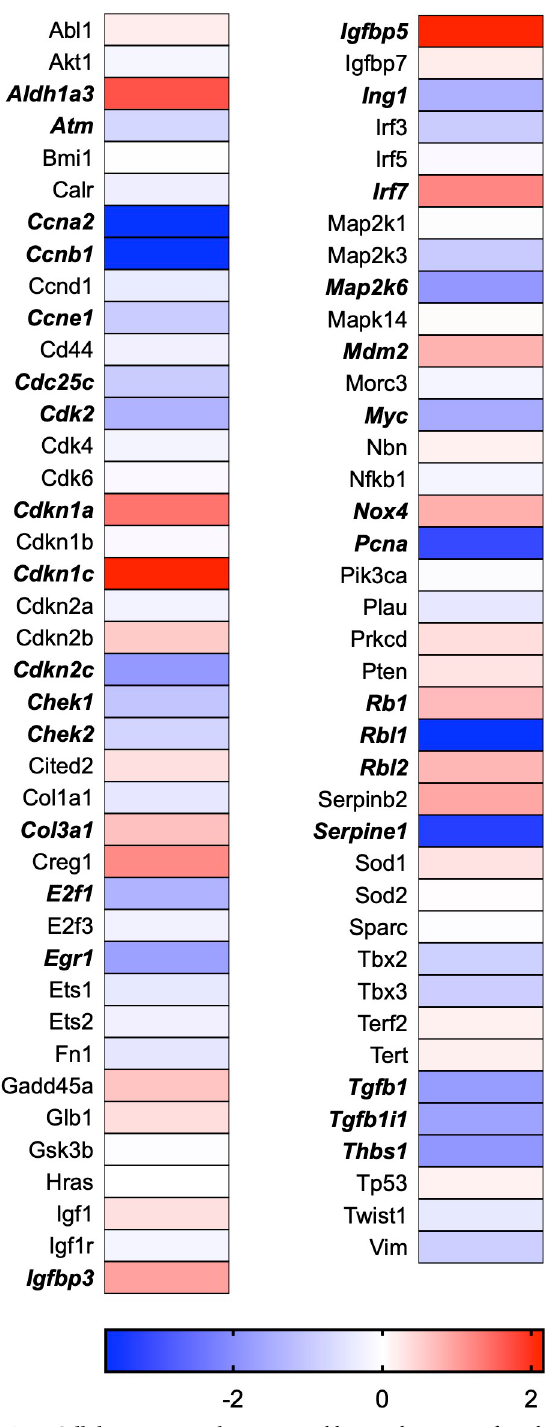
Fig 5. Cellular senescence heat map. Bold text indicates significantly altered gene